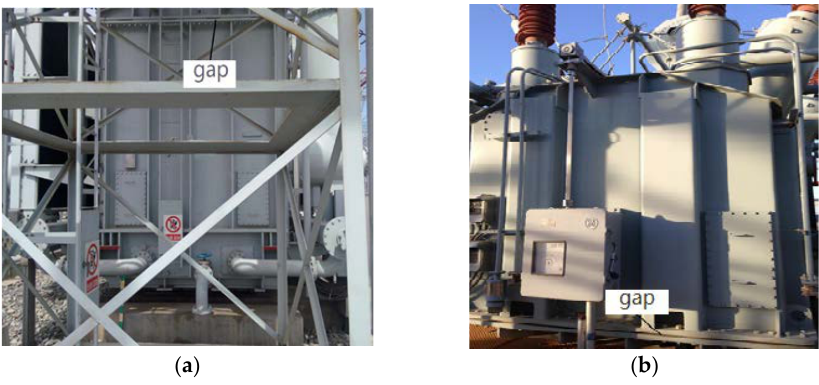
Figure 1. Schematic of transformer gap: ( a ) Gap of top lid and tank and ( b ) Gap of tank and pedestal.